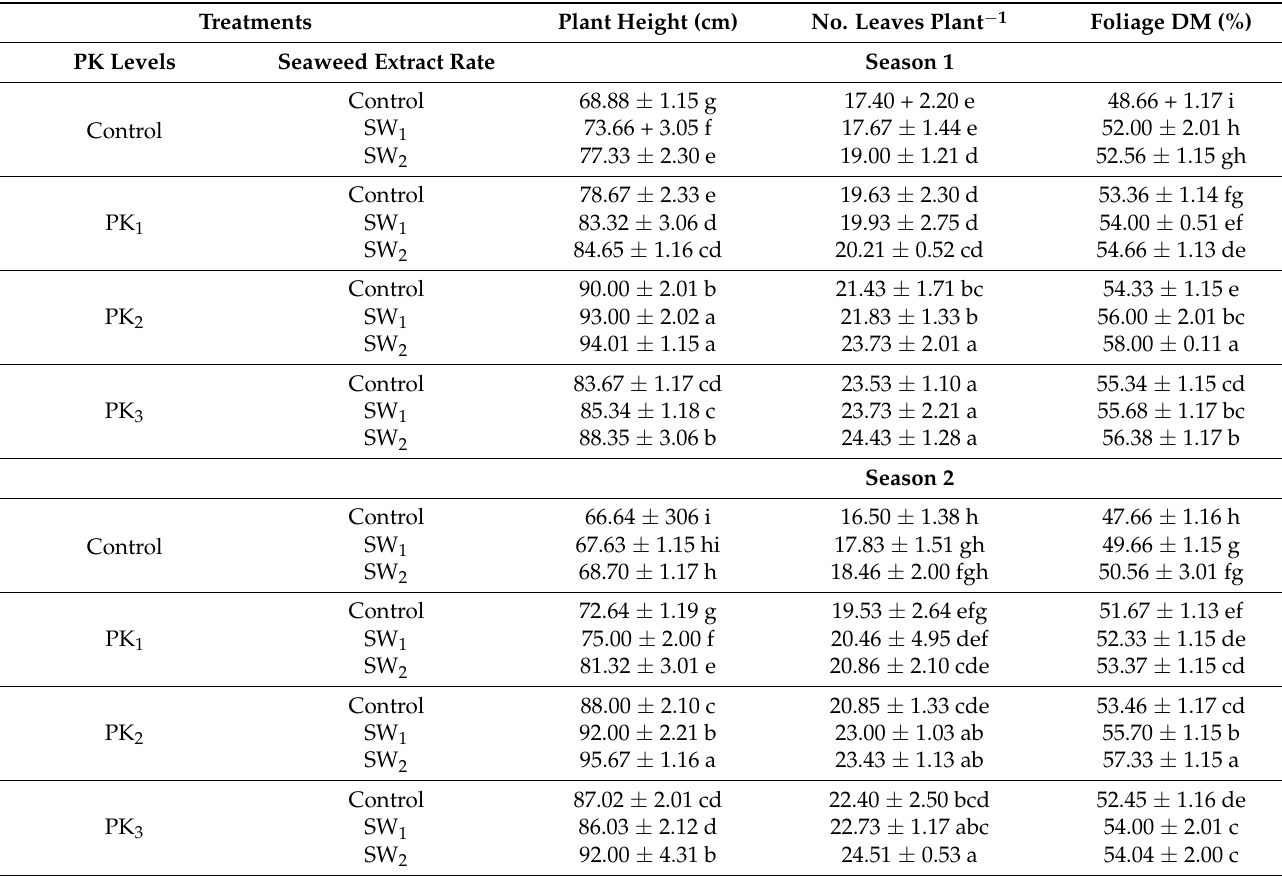
Table 3. Vegetative growth parameters of globe artichoke as affected by interaction between PK fertilizer levels and seaweed extract